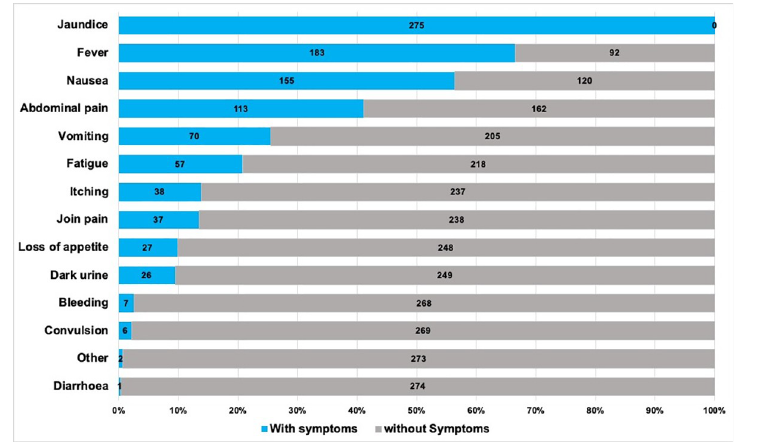
Fig 3. Presenting symptoms of reported AJS